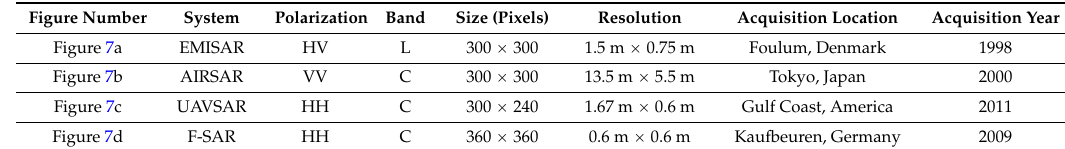
Figure 7. ( a ) ElectroMagnetic Institute Synthetic Aperture Radar (EMISAR) image; ( b ) Airborne Synthetic Aperture Radar (AIRSAR) image; ( c ) Uninhabited Aerial Vehicle Synthetic Aperture Radar (UAVSAR) image; and ( d ) Flugzeug Synthetic Aperture Radar (F-SAR) image. Table 2. Parameters of four SAR images used in experiments, where HV, HH and VV denote the polarization models for horizontal transmit and vertical receive, horizontal transmit and horizontal receive, and vertical transmit and vertical receive, respectively.